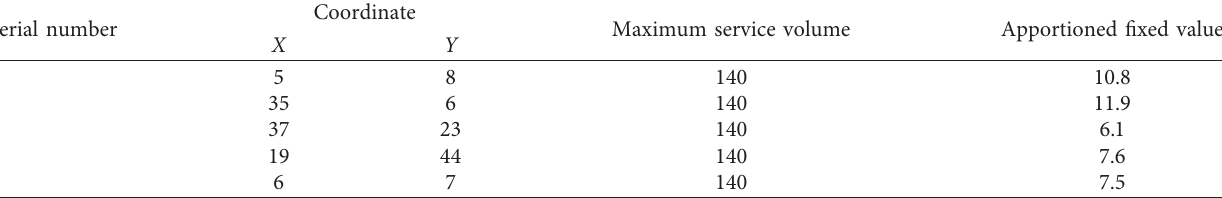
Table 4: Transit station information.